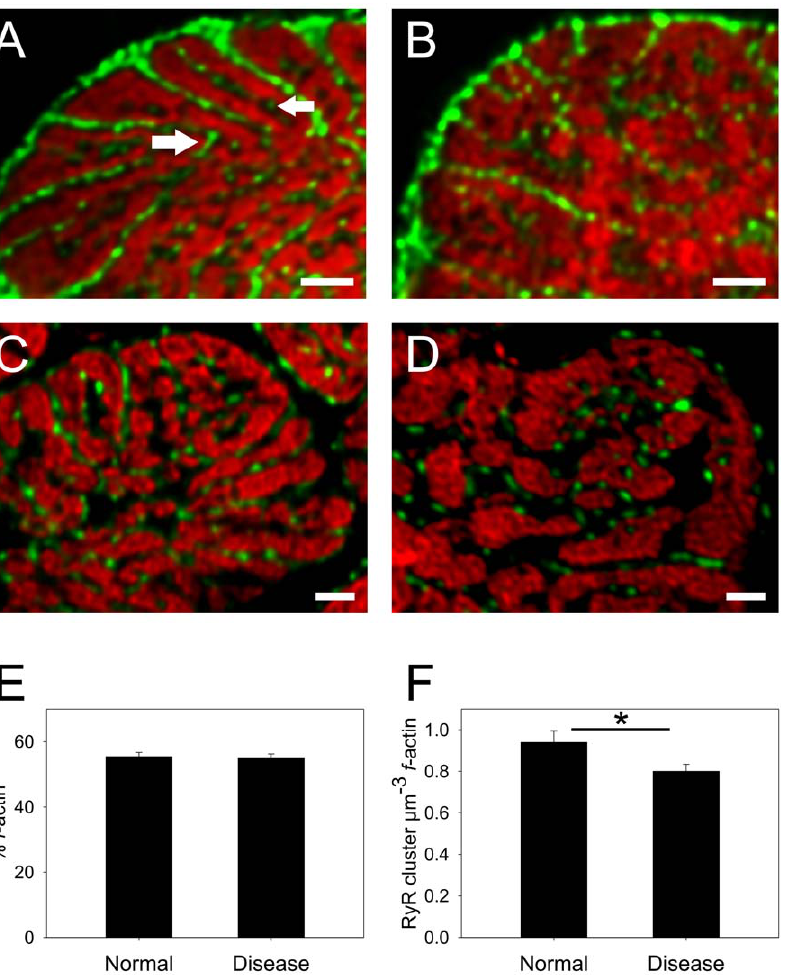
Figure 5. Comparison of myofilaments, t-tubules and RyR localization. Panels A and B show transverse sections of normal and diseased myocytes respectively, labelled for Cav3 and f -actin. The contractile machinery is surrounded by Cav3 labelling at this plane which was selected to be centred at the z-line. Gaps in the centre of contractile bundles contain isolated Cav3 labelling (small white arrow) and inspection of adjacent sections show that this arises from axial tubules that join transverse tubules outside the presented image plane. A connection between adjacent radial t- tubules is indicated by the large arrow. Panels C and D show transverse sections of normal and diseased tissue (respectively) labelled for RyR and f - actin. It is apparent that each contractile bundle is surrounded by several RyR clusters. All images are projections of 4 slices with z depth of 0.8 m m. Panel E shows analysis of cell volume occupied by f -actin and no significant difference (P=0.81) exists between normal and diseased tissue. Panel F shows analysis of the number of RyR clusters per m m 3 of f -actin and there was a significant reduction in the density of RyR clusters in disease cells (*P=0.03). Scale bars are 2 m m.